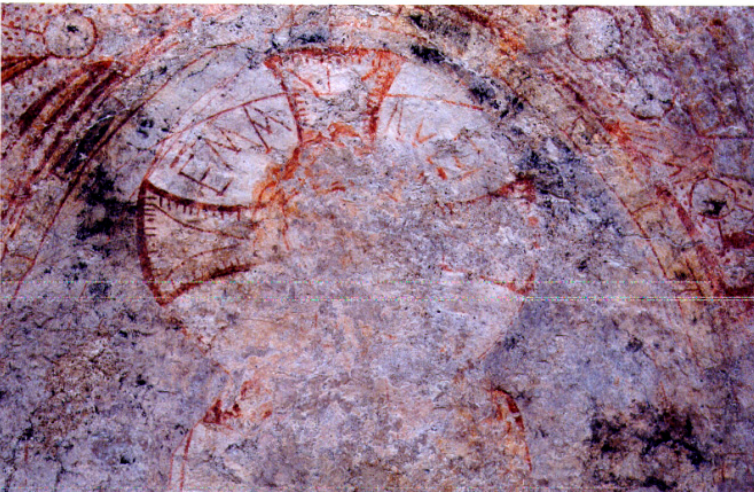
Figure 9. Sant Miquel de Terrassa, wall paintings. Inscription Em(m)anu(el). © ARCOR.